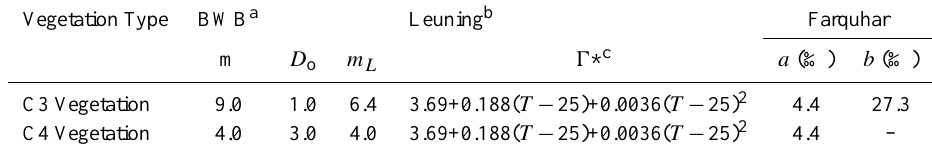
Table 2. Model Parameters for the BWB and Leuning stomatal conductance models according to vegetation photosynthetic pathway.